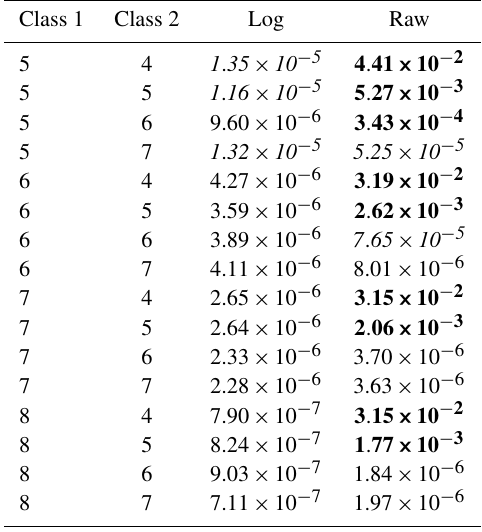
Table 1. Validation of the SimDol2D scenario with DHT: max- imum errors across all iterations for different retained digits. The logarithmic case shows a clear advantage compared to the raw vari- ables, being consistently more accurate. For this use case the total error should not exceed roughly 1 × 10 − 5 . The unacceptable errors (leading to unphysical simulation results) are encoded in bold fonts; italic font is used for acceptable simulations and normal fonts are used for simulations with negligible accuracy